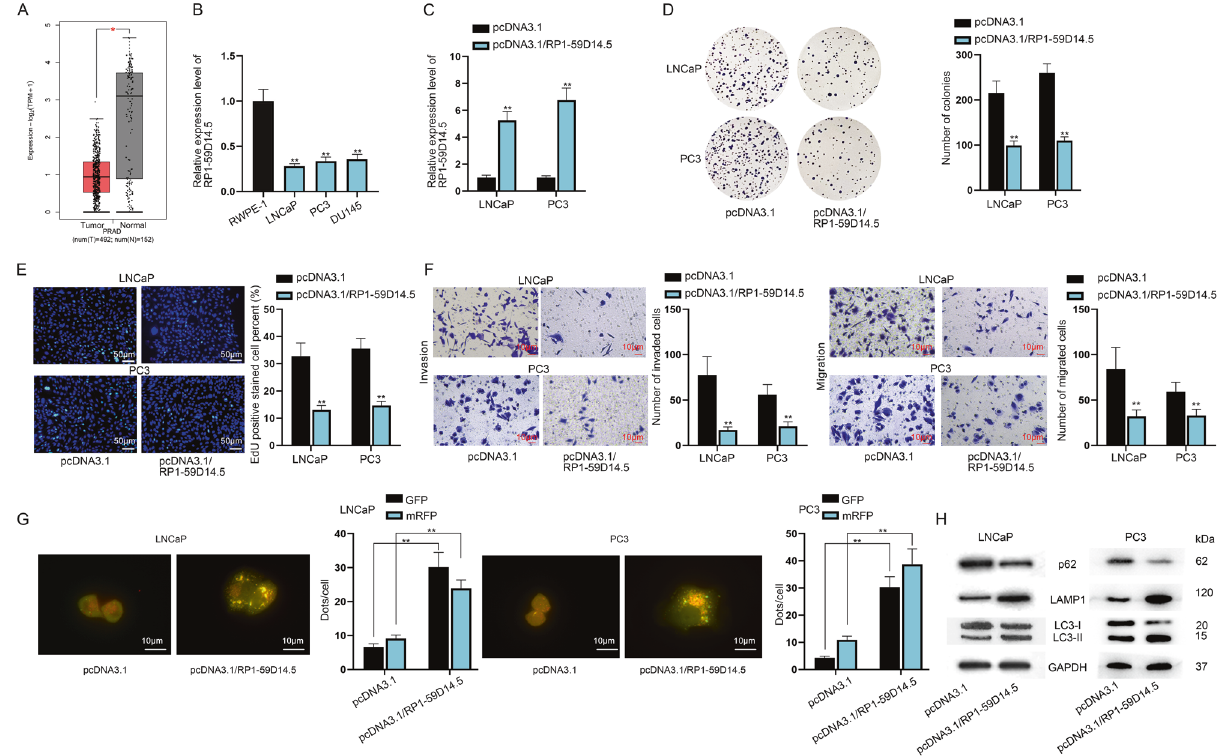
Fig. 1 RP1-59D14.5 inhibits cell proliferation, migration and invasion while promotes cell autophagy in PCa. A Box plot displayed RP1- 59D14.5 expression in PRAD tissues from GEPIA2. T: tumor; N: normal. B RT-qPCR analyzed RP1-59D14.5 expression in PCa cell lines (LNCaP, PC3, and DU145) and REPE-1 cell. C Overexpression of RP1-59D14.5 was veri fi ed via RT-qPCR. D , E Colony formation and EdU assays assessed the proliferation of RP1-59D14.5-overexpressed PCa cells. Scale bar = 50 μ m. F . Transwell assays detected the invasion and migration of